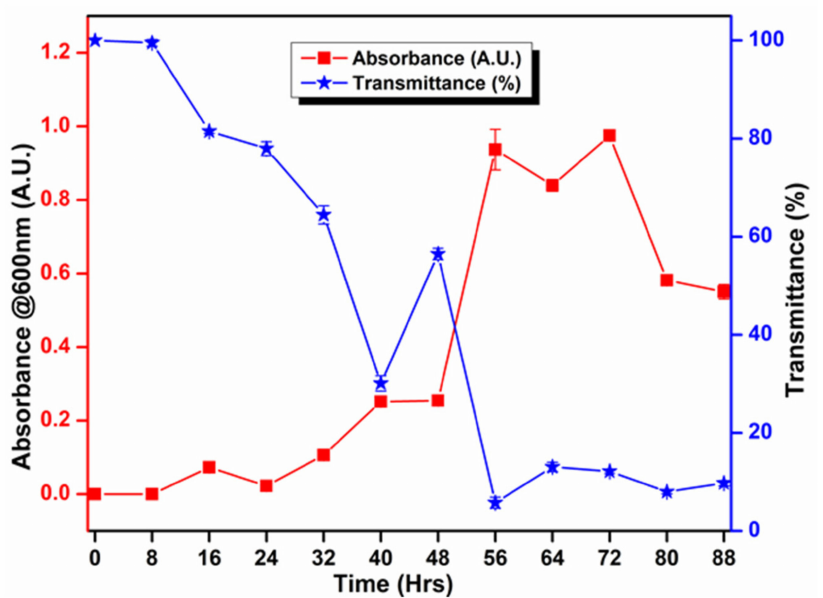
Figure 3. Growth pattern of B. altitudinis RSP75 in BMS medium supplemented with CMC as the sole source of carbon.